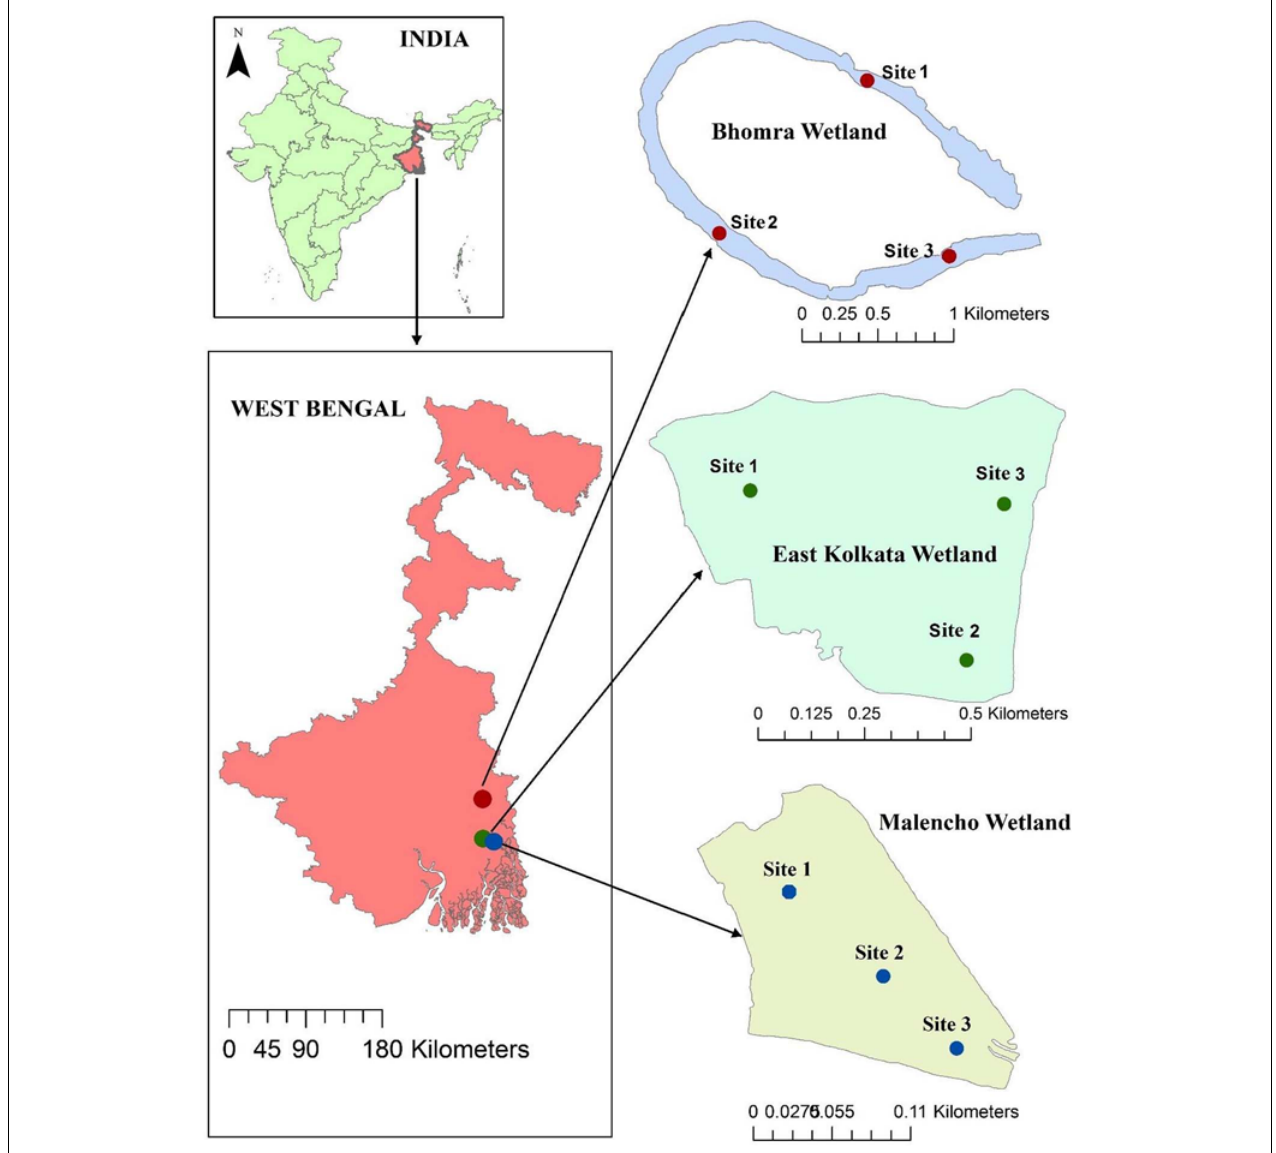
FIGURE 1 | Geographical location of each sampling site in three different wetland